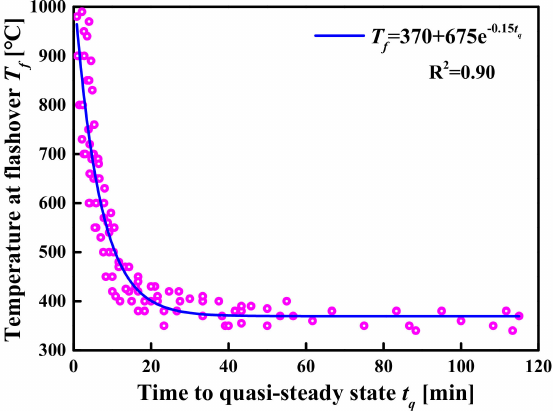
Figure 23. The evolution relationship between the T f and the t f .